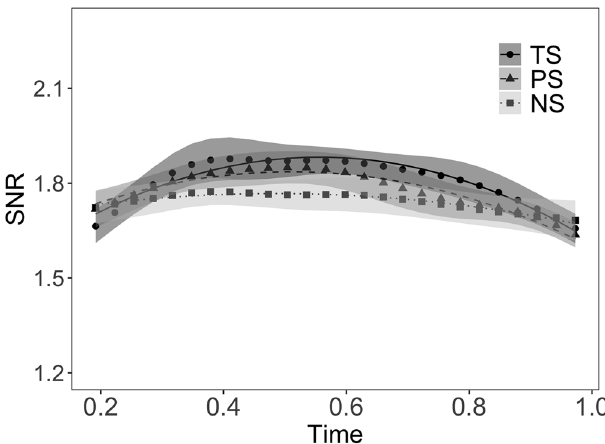
Figure 2. Effect of morpheme status for suffixes. The SSVEP time course from RESS component optimized for 12.50 Hz is shown. Symbols represent EEG data; shadows represent standard error of the means (SEMs) adjusted to correctly reflect the variance in the within-subject design (Morey 2008). Lines represent growth curve analysis model fit. TS = Truly suffixed, PS = Pseudo-suffixed, NS = Non-suffixed. The figure was created using R 56 (http:// www.R- proje ct. org) package ggplot2 (https:// cran.r- proje ct. org/ web/ packa ges/ ggplo t2/ index. html).